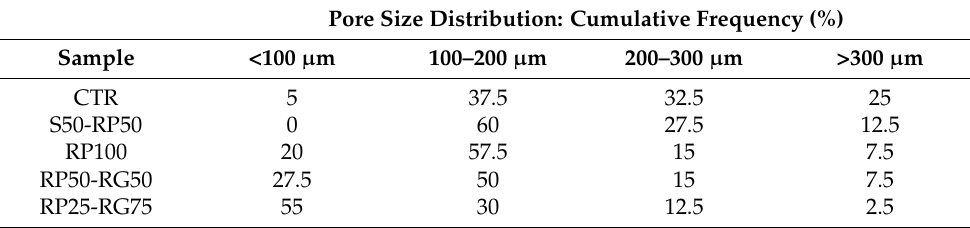
Table 2. Macro-porosity by image analysis: Pore size distribution. Pore Size Distribution: Cumulative Frequency (%)